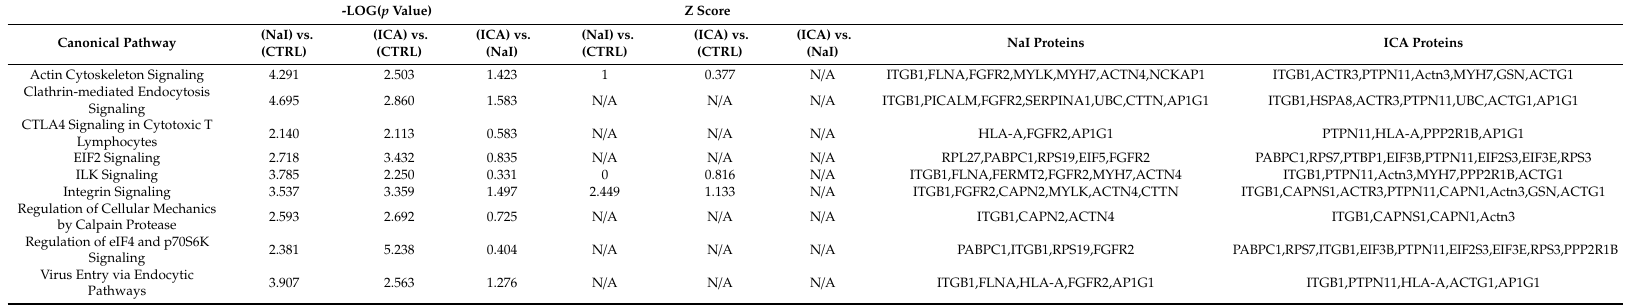
Table 3. Common pathways list a ff ected in NaI-treated animals and ICM-treated